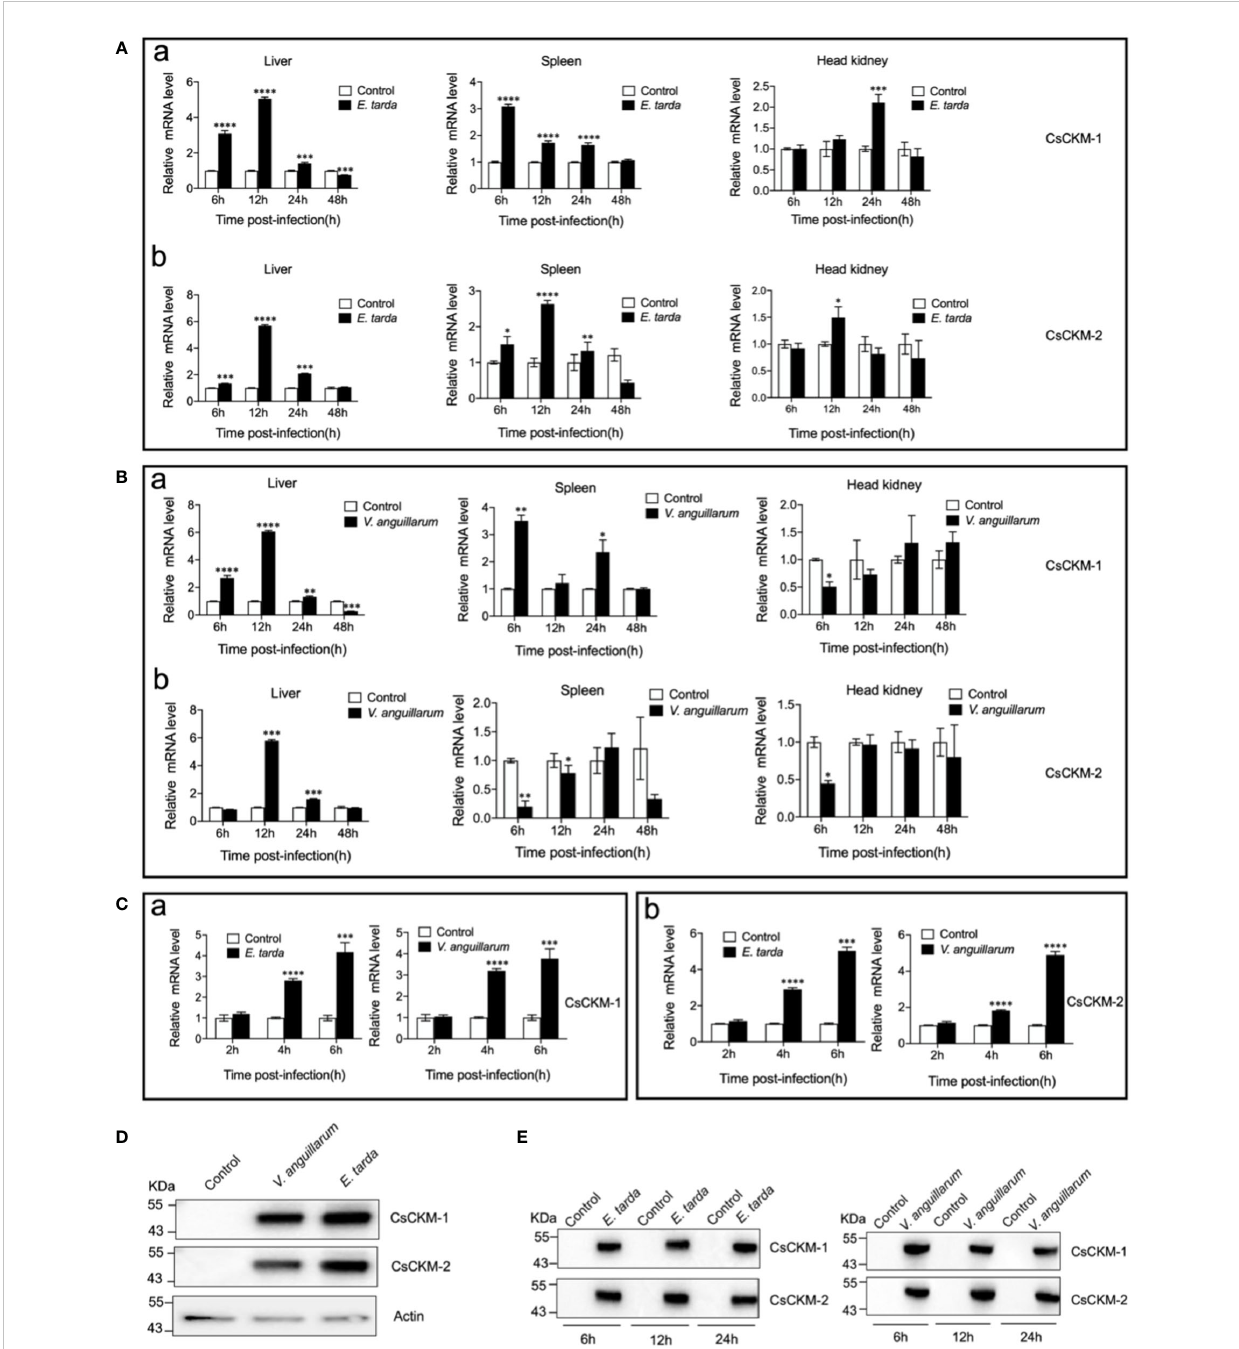
FIGURE 2 The effect of bacterial infection on CsCKM-1/2 expression and extracellular release. (A, B) Tongue sole were infected with or without (control) Edwardsiella tarda (A) or Vibrio anguillarum (B) , and the expression levels of CsCKM-1 (a) and CsCKM-2 (b) in liver, spleen and head kidney were determined by qRT-PCR at various time points. (C) Tongue sole PBLs were infected with or without (control) E. tarda or V. anguillarum , and the expression of CsCKM-1(a) and CsCKM-2 (b) was determined by qRT-PCR. In all panels, the expression level in the control fi sh/cells was set as 1. Values are the means of triplicate assays and shown as means ± SD. *P < 0.05; **P < 0.01; ***P < 0.001; ****P < 0.0001. (D) Tongue sole PBLs were infected with or without (control) E. tarda or V. anguillarum . Extracellular release of CsCKM-1/2 was detected by immunoblotting using anti-CsCKM- 1/2 antibodies. b -actin was used as a loading control. (E) Tongue sole were infected with or without (control) E. tarda or V. anguillarum for 6 to 24 h. CsCKM-1/2 in serum were determined by immunoblotting as